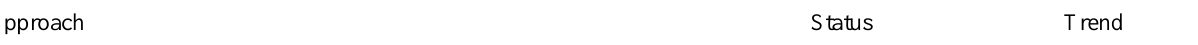
Table 1. Overview of approaches to validation in 11 studies that measured the status of forest condition and 16 studies that measured the trend in forest condition, from a total of 19 studies. Approach Status Trend Asked more than one group (triangulation) 5 6 Validated by other means 3 2 4